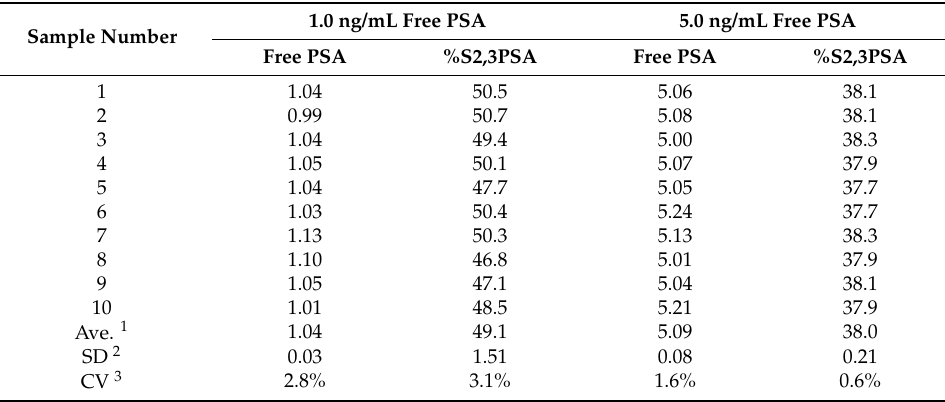
Table 1. Assay reproducibility of S2,3PSA test.